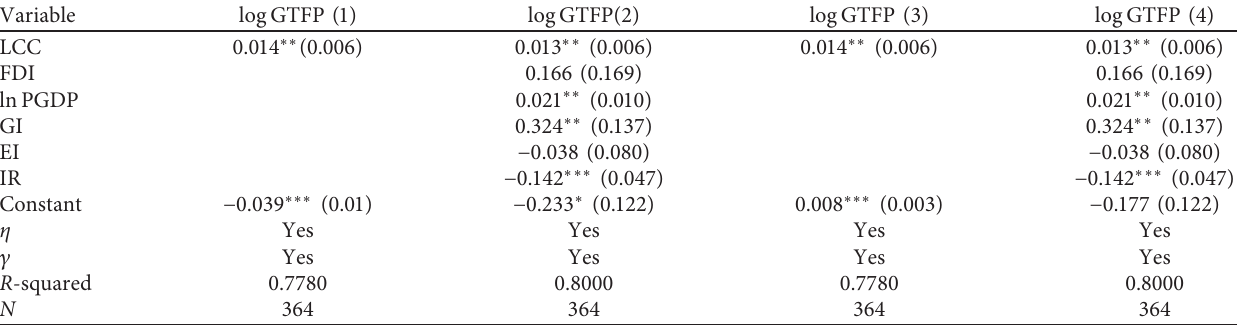
Table 4: Low-carbon pilot policy on GTFP of